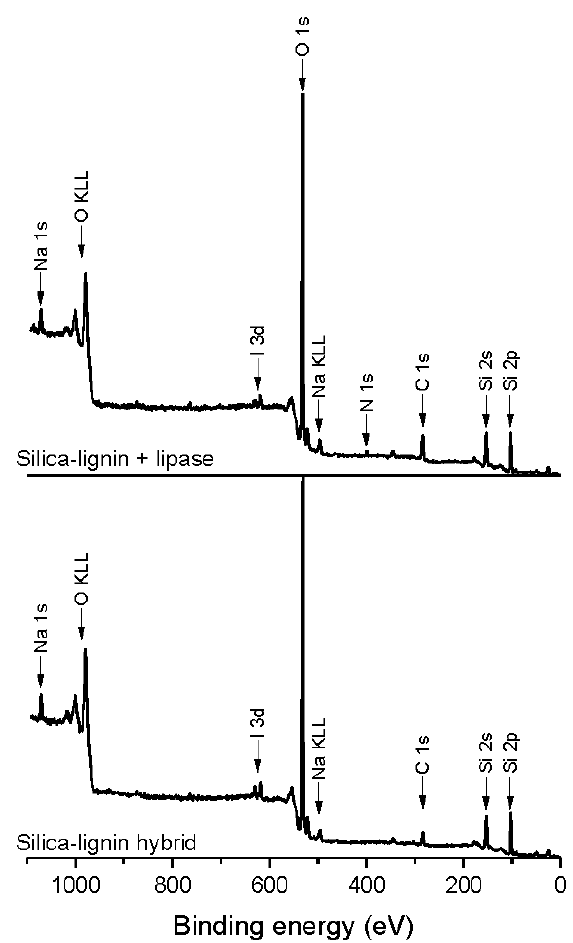
Figure 3. X-ray photoelectron spectra of silica-lignin matrix and silica-lignin + lipase products Figure 3. X ‐ ray photoelectron spectra of silica ‐ lignin matrix and silica ‐ lignin + lipase products after after immobilization.